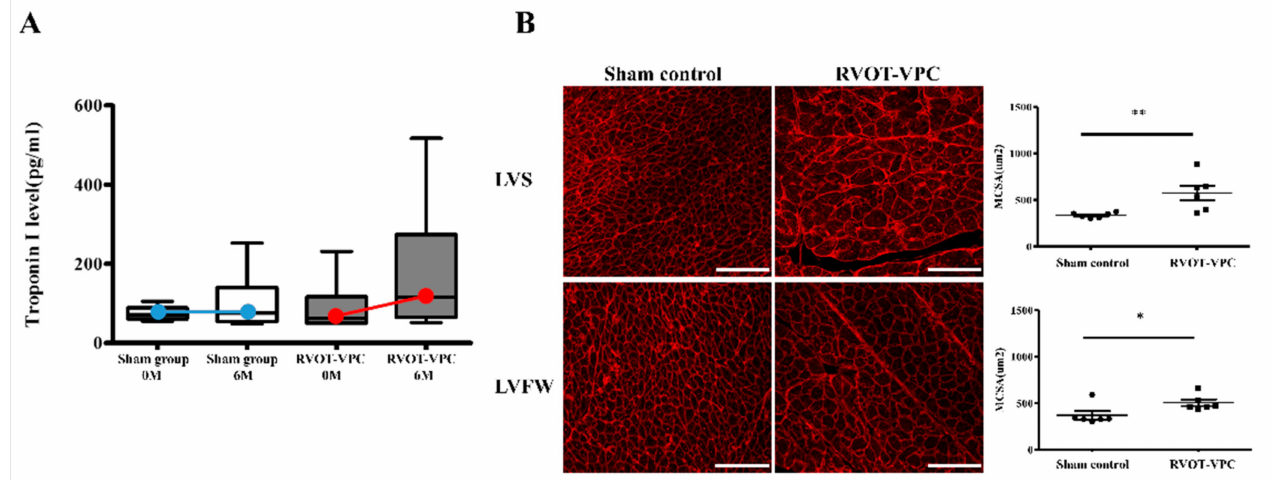
Figure 2. Elevated serum cardiac troponin I level and cardiomyocyte enlargement developed in left ventricular myocardium following 6-month RVOT bigeminy VPCs. ( A ) Before VPC creating, serum cardiac troponin I levels were similar between RVOT-VPC group and sham control group. However, the RVOT-VPC group had higher serum cardiac troponin I level than the sham control group at the 6-month follow-up, although the difference did not reach statistical significance. The changes in cardiac troponin I level in the RVOT VPC group and sham control group were illustrated by the slopes of the red line and blue line, respectively. ( B ) Immunofluorescence study with wheat germ agglutinin stain for the cell membrane of cardiomyocytes showed that the RVOT-VPC group had significantly larger cardiomyocyte size than the sham control group at both the left ventricular septum (LVS) ( p = 0.0043) and LV free wall (LVFW) ( p = 0.0041). Round dot: Sham control group; Square dot: RVOT-VPC group. Each datum in this figure represents the average of 1000 cells per sample. MCSA: myocyte cross-sectional area. Scale bar = 75 µ m. *: p < 0.05; **: p <